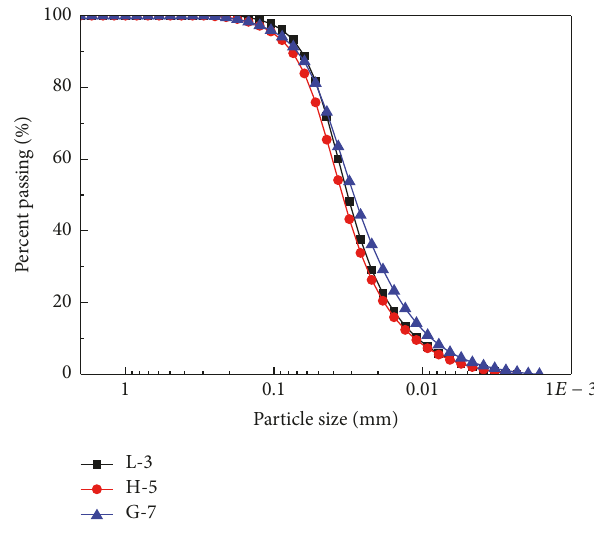
Figure 2: Result of laser diffraction technique.